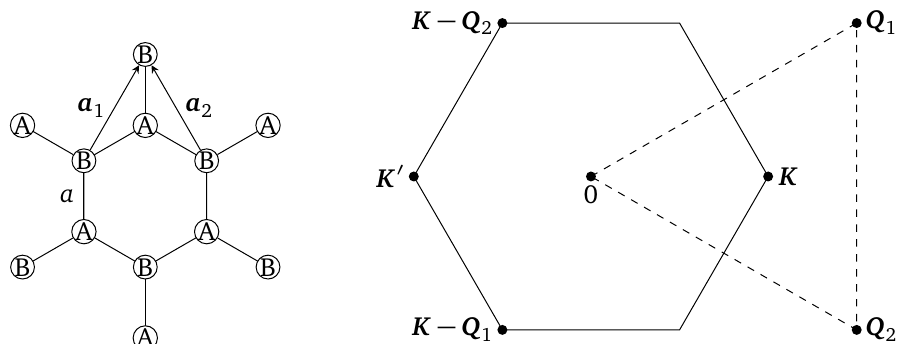
Figure 1: Left panel: conventions for graphene lattice. Two linearly independent Bravais lattice (translation) vectors a , a are shown. The distance between neigh- 1 2 boring carbon atoms is a , as marked. Right panel: Graphene Brillouin zone and some other useful wavevectors. The wavevectors Q and Q are basis vectors for the 1 2 reciprocal lattice. The K point (also denoted K point in the text) is the centroid of the triangle formed by the origin, Q and Q . The two other Brillouin zone corners 1 2 K − Q and K − Q are equivalent to K as quasimomenta, and are obtained from the 1 2 latter by C 3